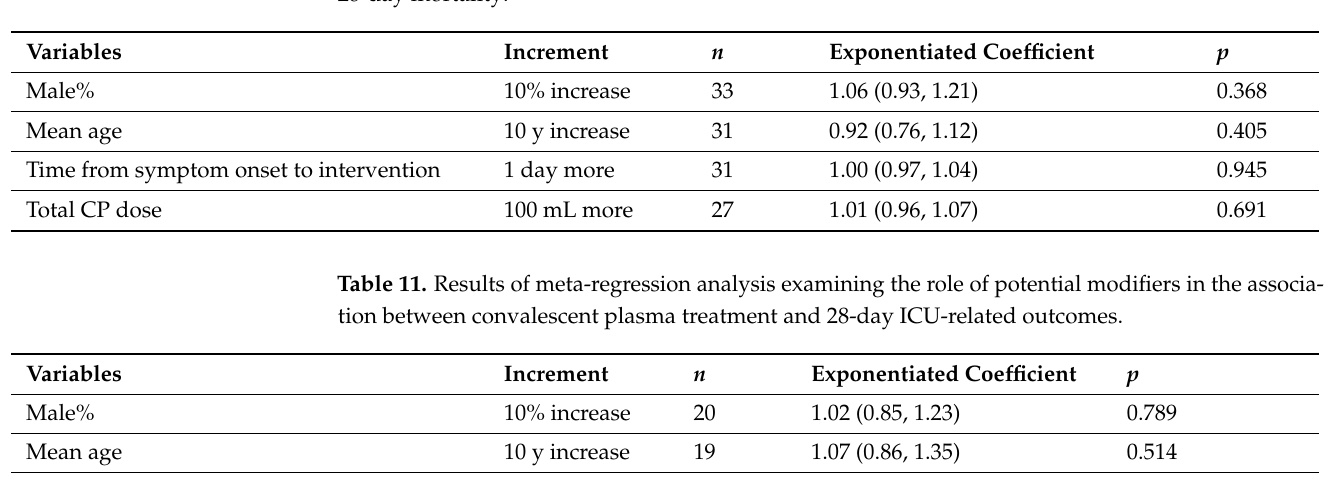
Table 10. Meta-regression on mortality (28-day). Results of meta-regression analysis examin- ing the role of potential modifiers in the association between convalescent plasma treatment and 28-day mortality.